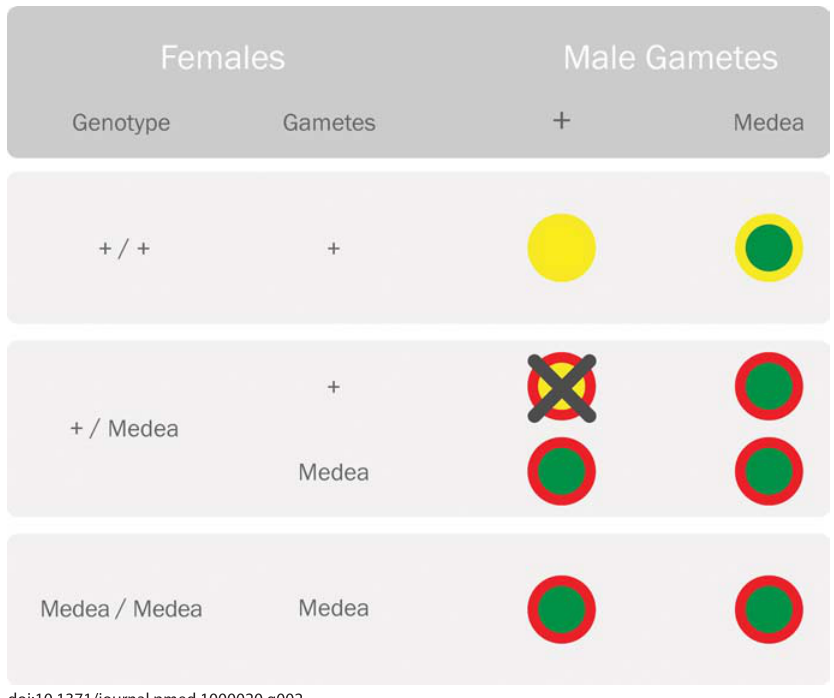
Figure 2. Parental Crosses Representing the Reproductive Advantage of the Medea Allele Females carrying the Medea allele produce a maternally expressed toxin (red outer circle) that is deleterious to their offspring. Offspring who carry the Medea allele are rescued by a zygotically expressed antidote (green inner circle) expressed by the same allele. Offspring of heterozygous females who do not inherit the Medea allele are killed by the toxin because they lack the antidote (yellow represents lack of the toxin/antidote). This distorts the offspring ratio in favor of the Medea